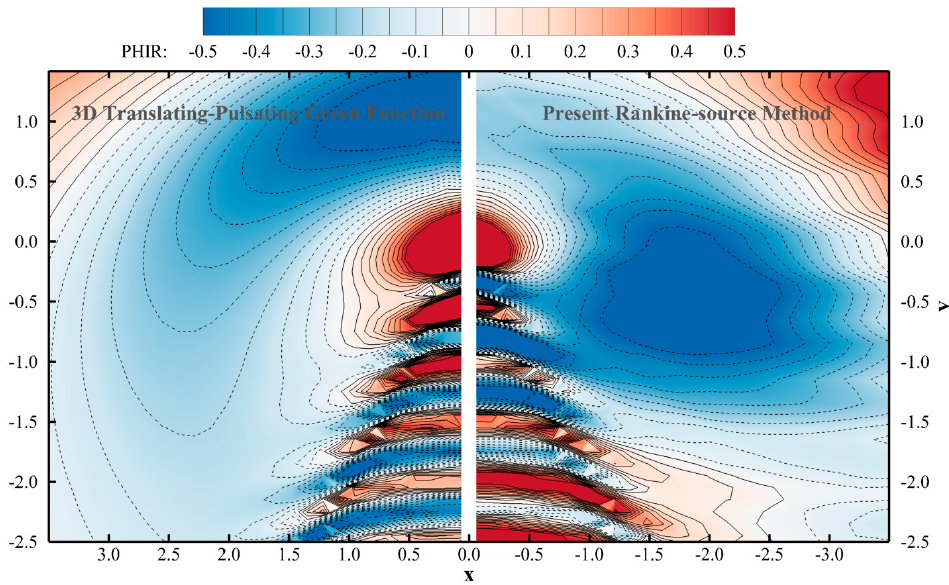
Figure 8. R [ ϕ ] by Green function and Rankine source methods at κ L = 1.0, F r = 0.2, τ = 0.2 and without Rayleigh damping µ c = 0.0 [39].